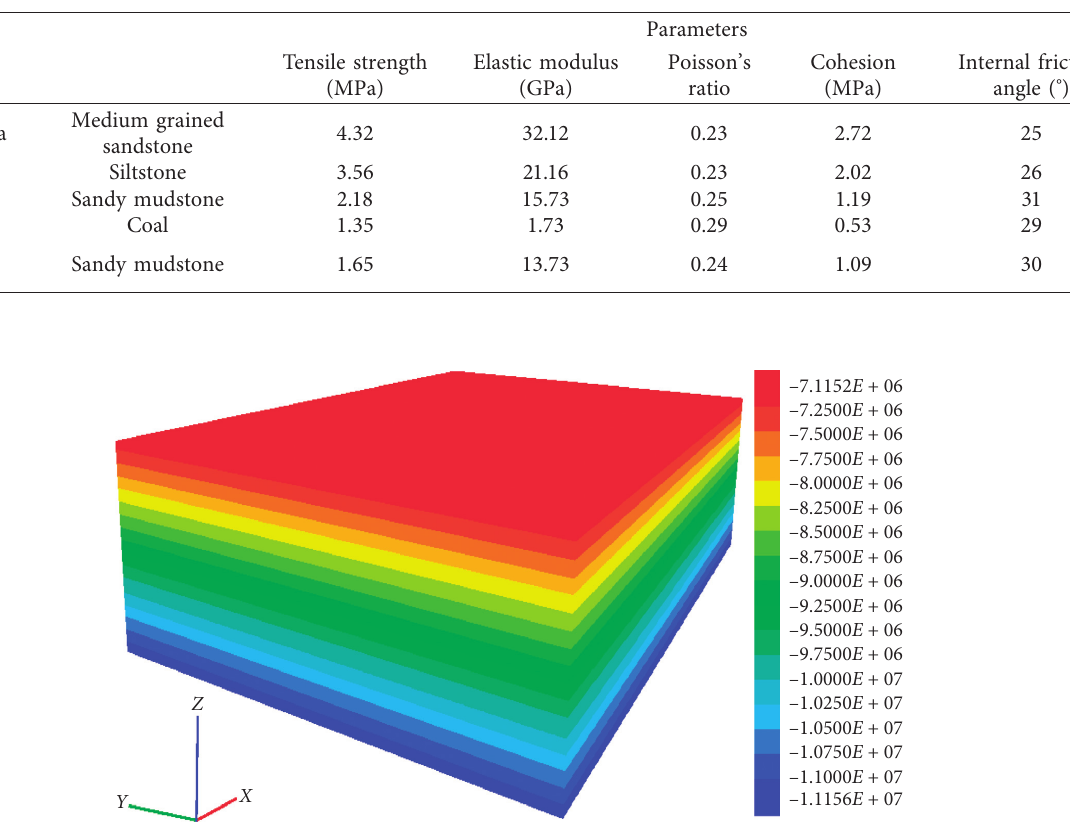
Figure 2: Model initial balance